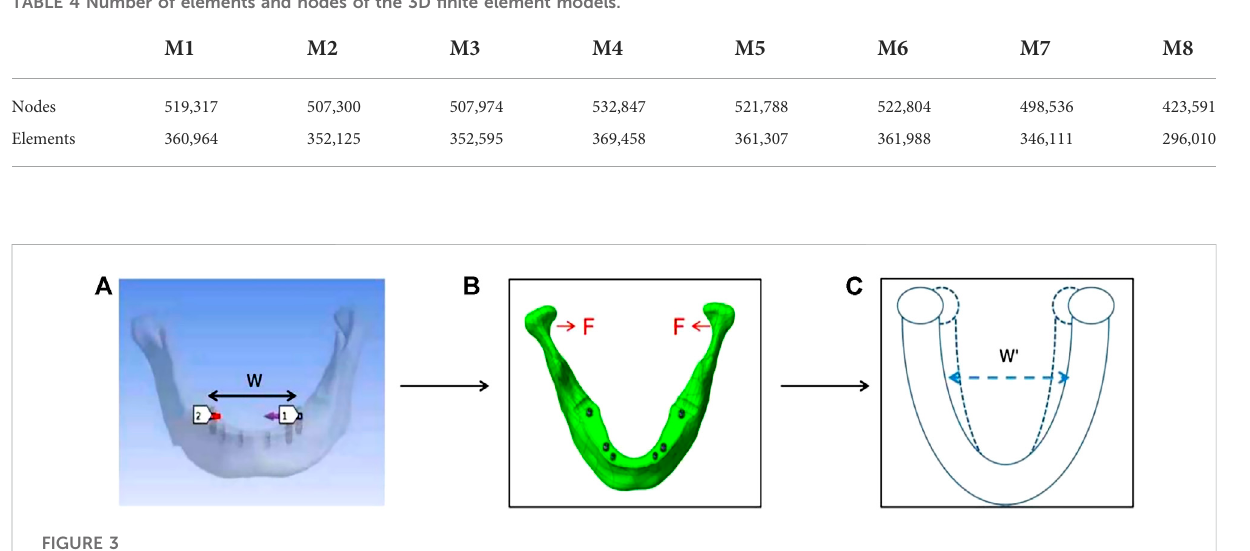
TABLE 4 Number of elements and nodes of the 3D fi nite element models.